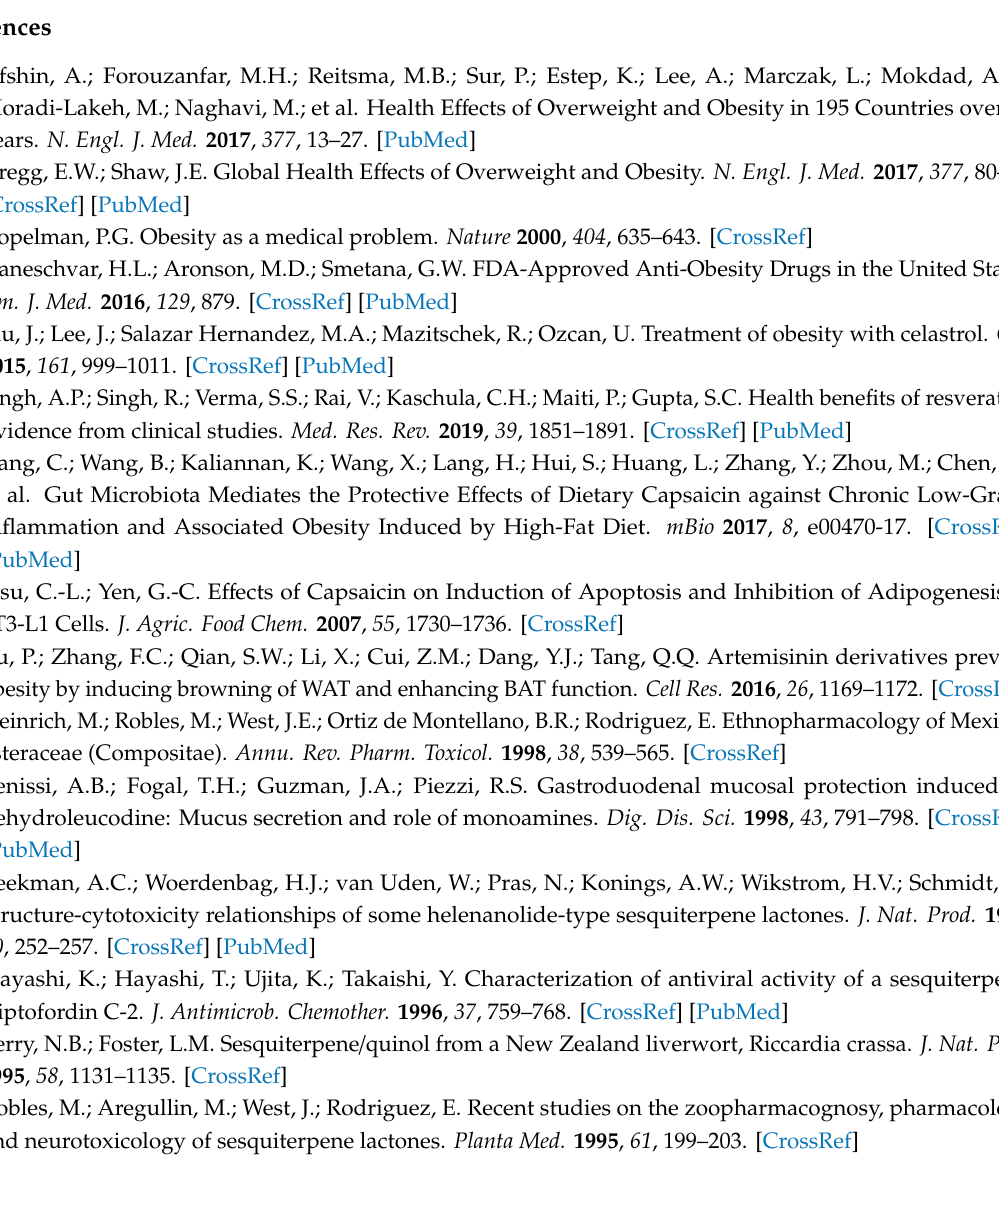
Figure S1: Lactucin does not cause toxicity in mice. Figure S2: The e ff ect of lactucin on hepatic lipogenesis. Table S1: Primers used in real-time quantitative PCR. Table S2: Anti-body used in western-blot and